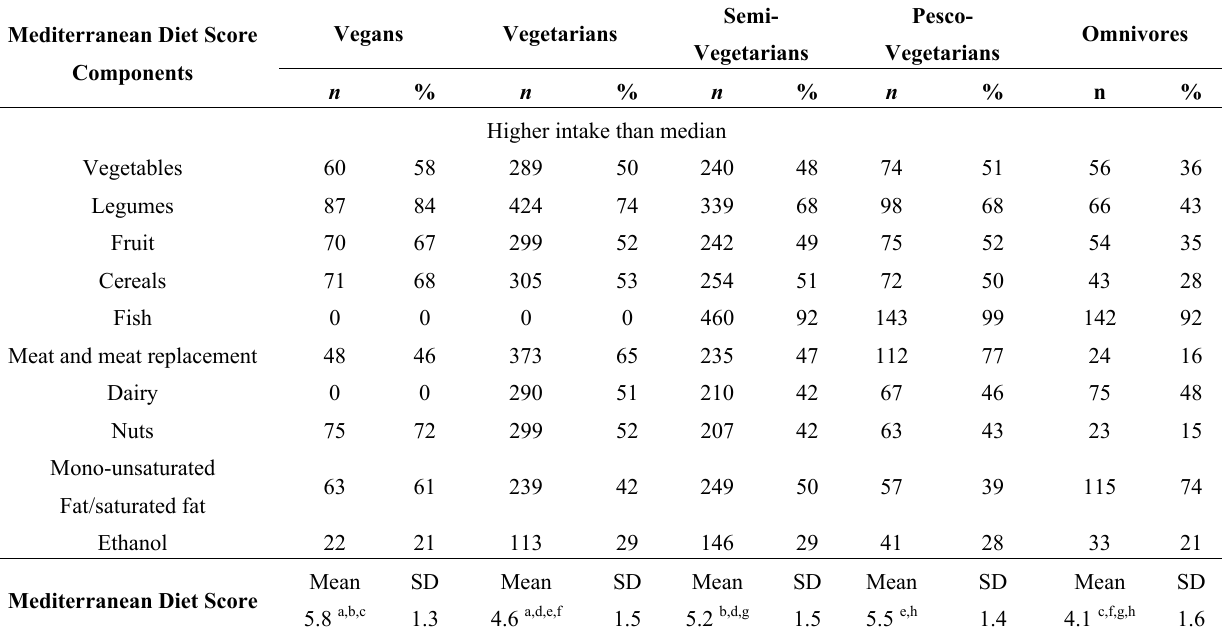
Table 4. Distribution across components and total score for the Mediterranean Diet Score ( n =